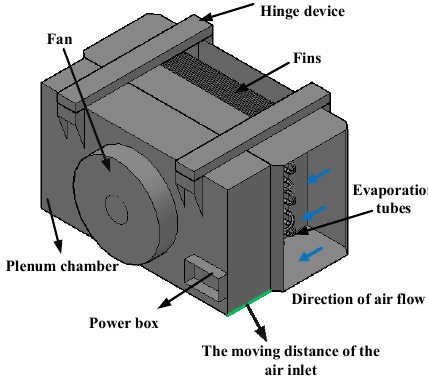
Figure 2. Concrete structure diagram of the air-cooler.